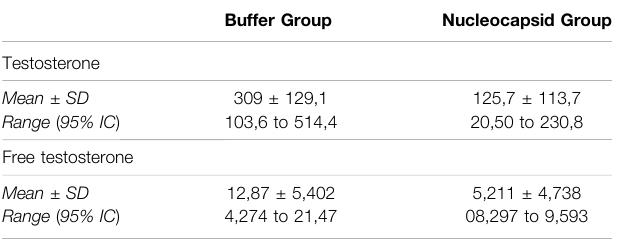
TABLE 3 | Total testosterone and free testosterone